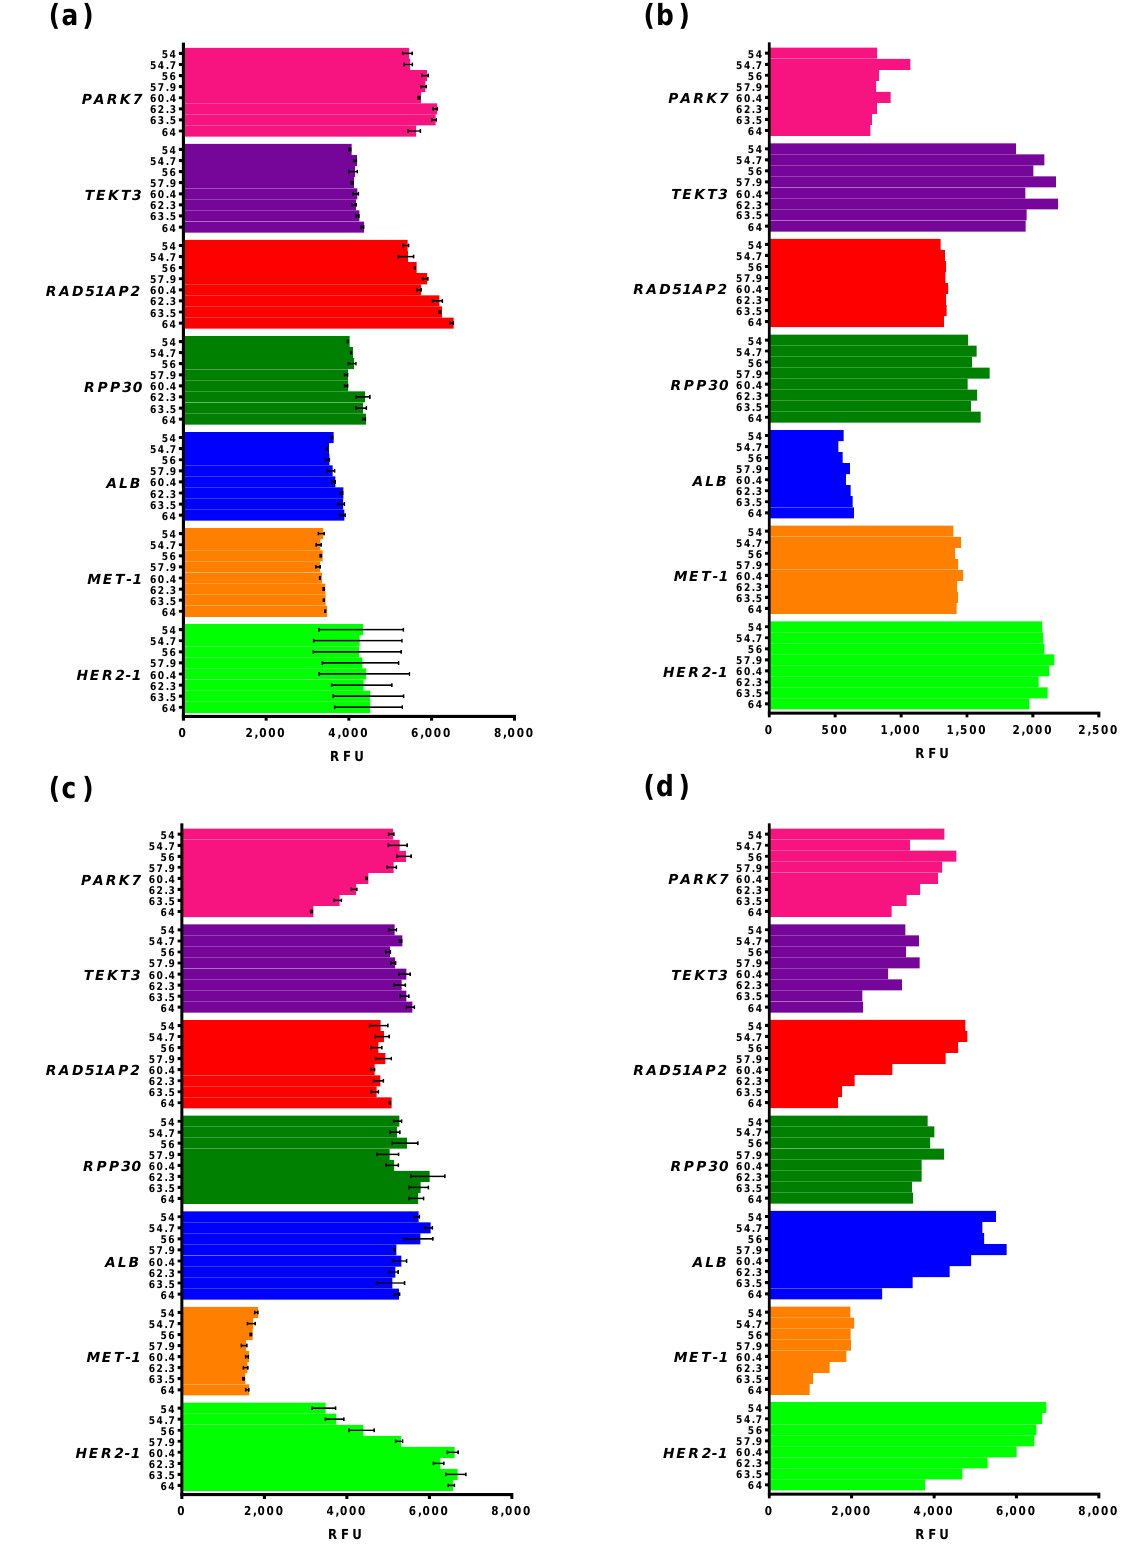
Figure 3. Fluorescence of monoplexes in qPCR and ddPCR. ( a ) Basic fluorescence of qPCR; ( b ) basic fluorescence of ddPCR; ( c ) end-point fluorescence after baseline subtraction of qPCR; ( d ) amplitude of end-point fluorescence ddPCR. Y-axis marks elongation temperature and monoplex, X-axis marks fluorescence in relative fluorescence units. Whiskers designate standard deviation in two